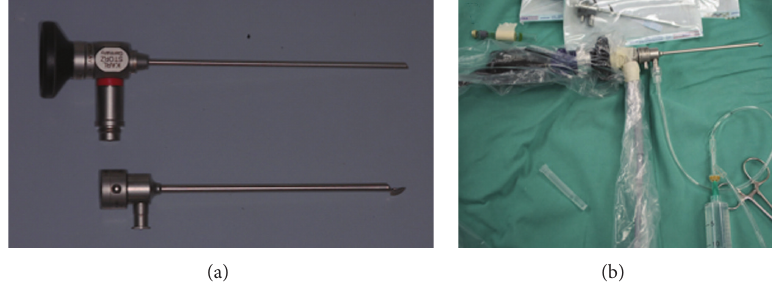
Figure 4: Endoscopic visualization techniques in oral surgery and implantology. (a) Support Endoscopy (SE). A Karl Storz optic (2.7 mm diameter) with support and irrigation sheath. (b) Immersion endoscopy (IE). Sterile equipment, Karl Storz optic (1.9mm diameter) with supporting sheath to accommodate the 1.9mm diameter optic connected to saline irrigation, tip modified to adapt to the dental